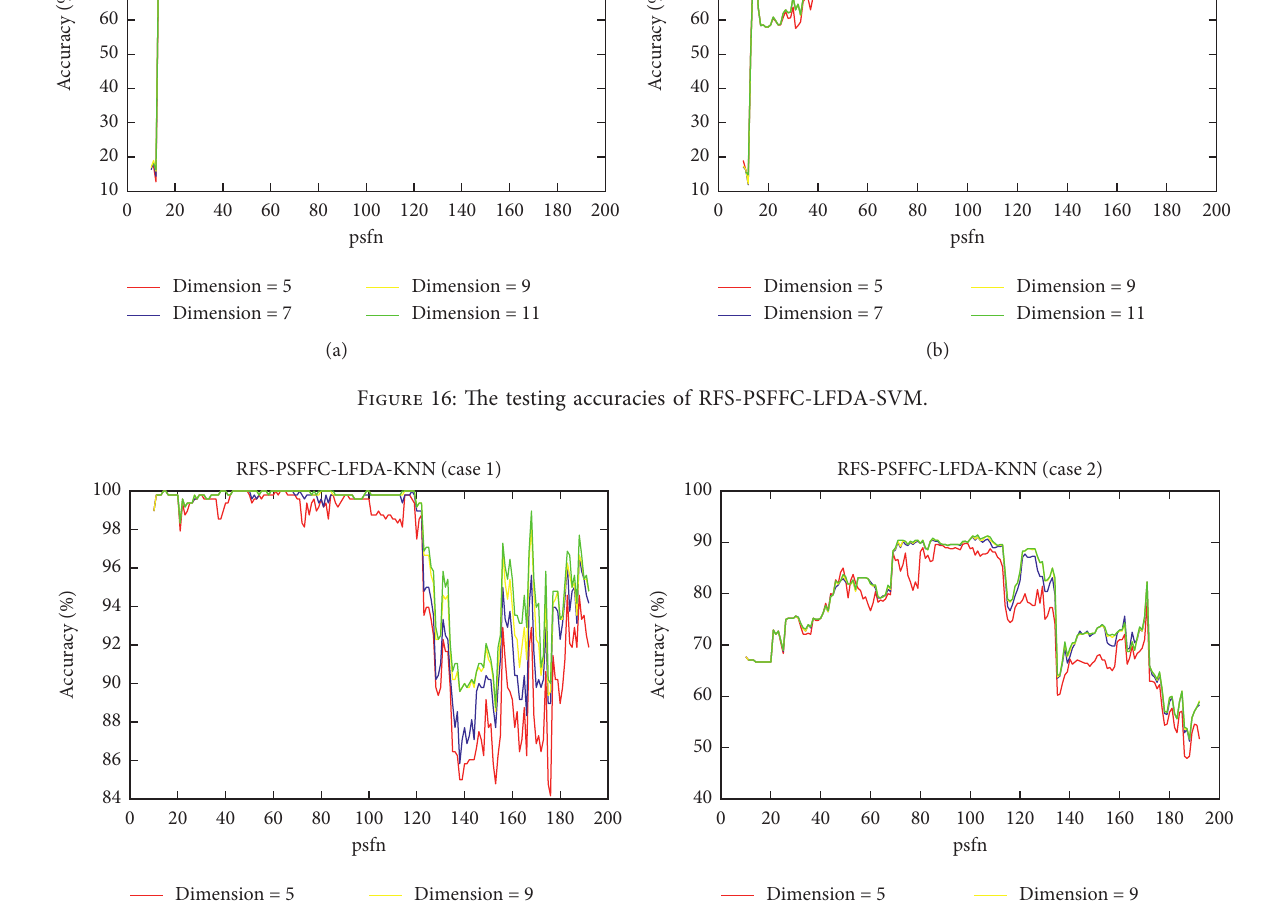
Figure 17: The testing accuracies of